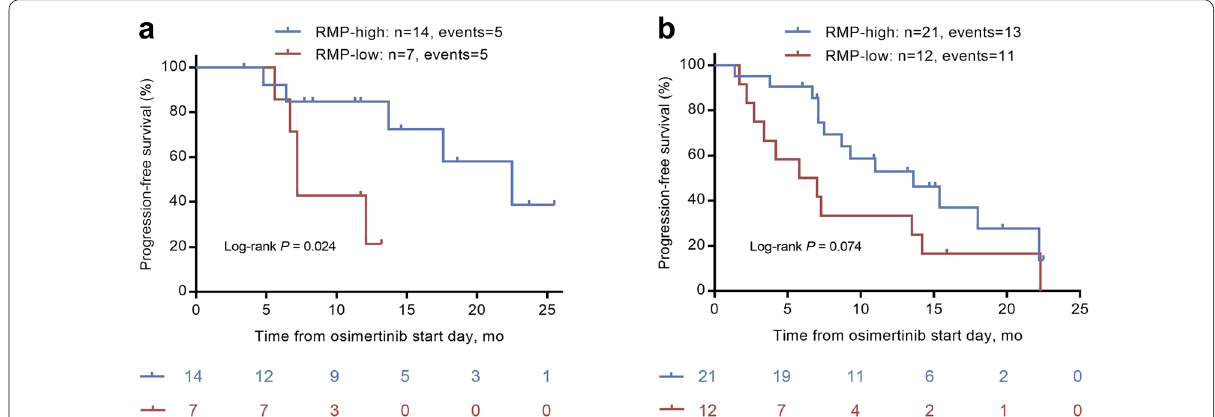
Fig. 6 Subgroup analysis according to TP53 status. a Progression-free survival (PFS) stratified by T790M relative mutation purity (RMP)-low and RMP-high patients in TP53 wild-type population (